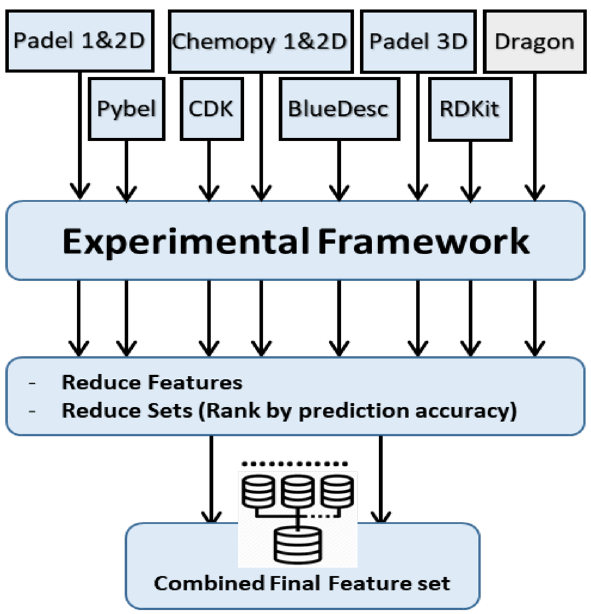
Figure 2. Testing and combining individual descriptor